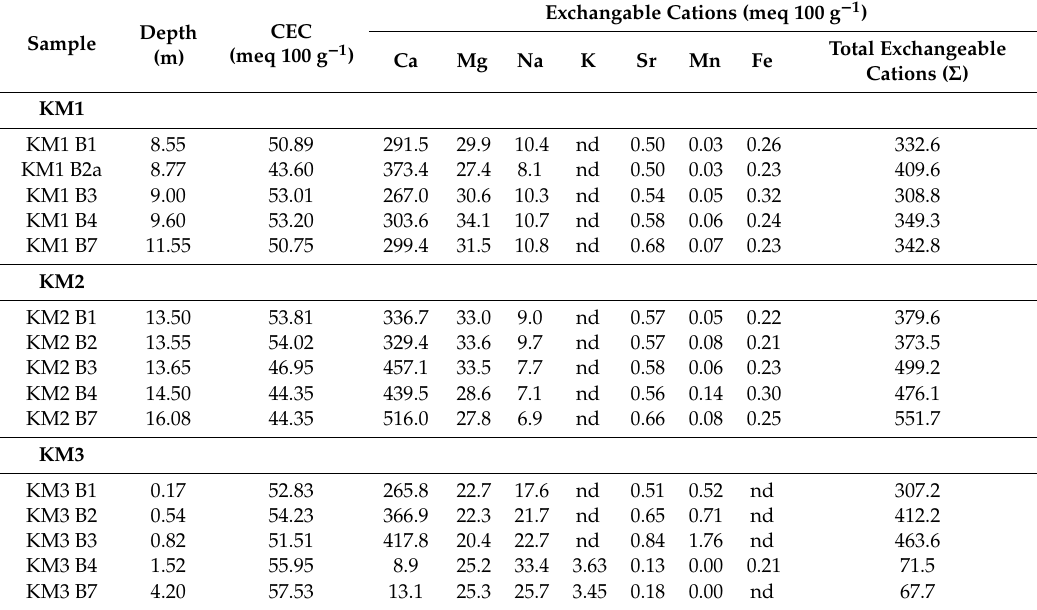
Table 6. Summary of cation exchange capacity and exchangeable cation chemistry for cores KM1, KM2 and